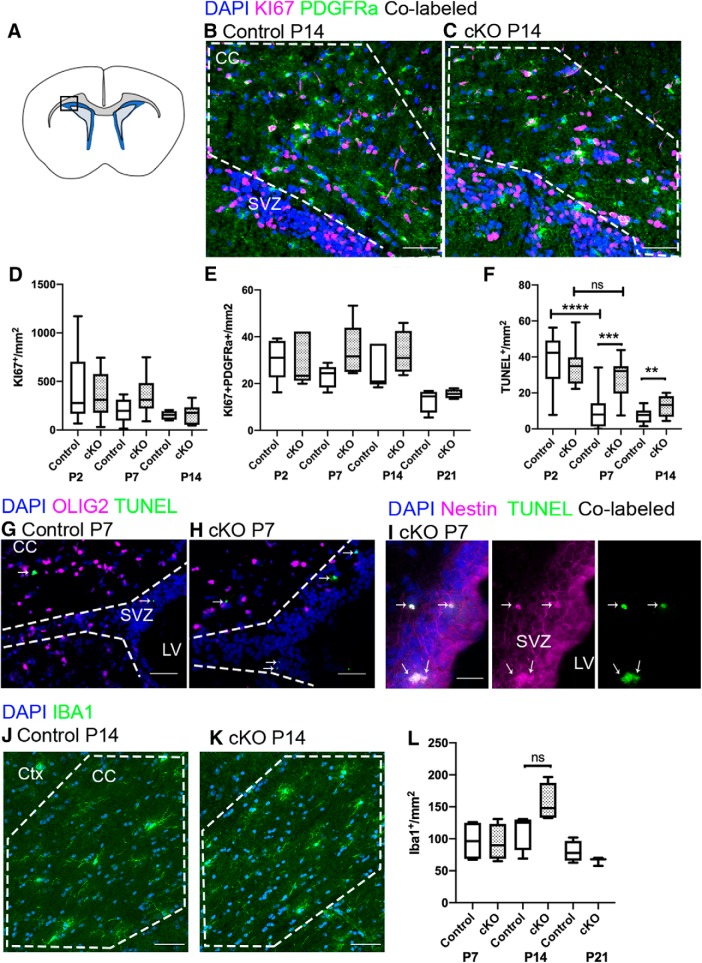
NSC survival is reduced in the Raldh2 cKO. A, Coronal section illustrating the regions imaged in the other panels. B, C, Control and cKO mice both have proliferating PDGFRα+ cells (green) identified by co-labeling (white) with KI67 (magenta), and non-proliferating PDGFRα+ cells. D, E, Control and cKO mice have comparable numbers of total KI67+ cells and KI67+PDGFRα+ cells at all time points. F, Between P2 and P7 in control animals, the number of TUNEL+ cells dropped significantly. Between P2 and P7 in cKO mice, TUNEL+ cell numbers were unchanged. At P7 and P14, cKO mice had significantly more TUNEL+ cells than controls. G, H, Dying cells identified by labeling with TUNEL (green, thin arrow) were present in the CC and SVZ (delineated by dotted lines) of both controls and cKO, though no OLIG2+ cells were co-labeled with TUNEL. I, In the cKO SVZ, 76% of all TUNEL+ cells were co-labeled by Nestin [magenta, co-labeled cells are white (thin arrow)]. J, K, Immunofluorescence for IBA1+ in the CC of control and cKO mice. L, Quantification of the number of IBA1+ cells shows no significant difference between groups; a transient increase in IBA1+ cells appears at P7 in cKO mice but does not reach significance. CC, corpus callosum; SVZ, subventricular zone; LV, lateral ventricle; cKO, conditional knock-out. Scale bars: 50 μm (B, C, G, H, J, K) and 25 μm (I). Box and whisker plot, box: 25th and 75th percentile, whiskers: minimum to maximum value, line at median. **p < 0.01, ***p < 0.001, ****p < 0.0001. ns = not significant.